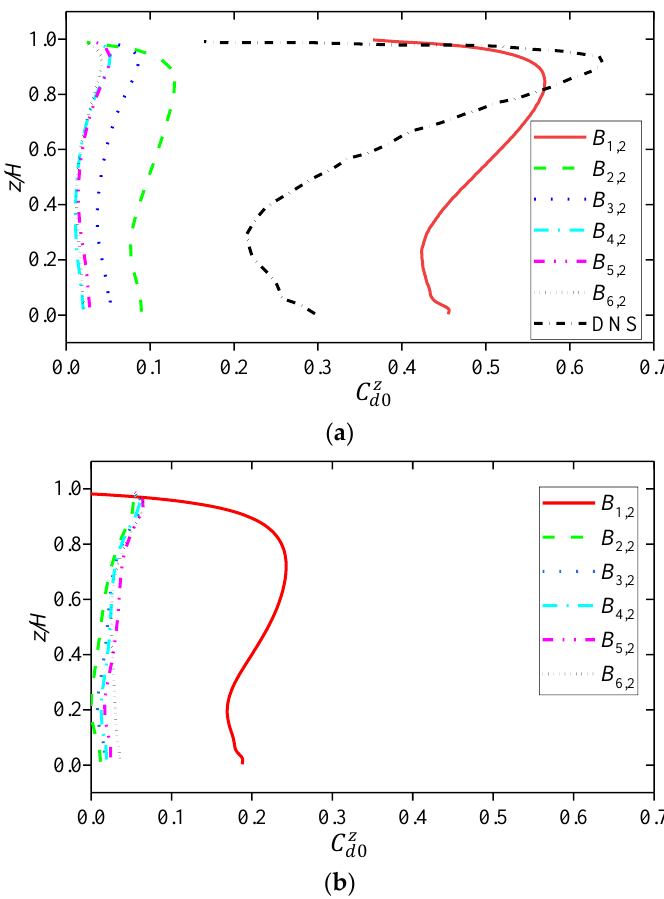
Figure 21. Sectional drag force coefficient 𝐶 𝑑0𝑧 for six pressure modules C 2 along wind direction for ( a ) DWP and ( b ) SWP. The DNS results are from the research of Santiago et al. [47]. Figure 22 further shows the heights H p, which correspond to the peak sectional drag coefficients for the two cases. H p of R 1 and R 2 in DWP are more discrete than those of R 1 in SWP. They increase to 0.89 H and stabilize from R 3, which is lower than 0.92 H in the streamlined case. For DWP, the approaching flow can penetrate R 3 along the wind direction, and then a local flow balance is established from C 3 onward. This can also be inferred from the stable drag force after R 3 in Figure 19a. The flow adjustment distance of three rows is shorter than the two rows in SWP due to the intense flow mixing caused by distorted wind passages. H p values fluctuate more significantly for C 1 , C 2, and C 4 for DWP than for SWP. H p of C 3 remains unchanged after R 3 for both cases, and we can infer that the skipping flow dominates the flow regime in the flow balance region. For DWP, H p of C 2 remains unchanged at 0.92 at R 4 and R 5 and then decreases to 0.89 at R 6. For SWP, H p of C 2 remains unchanged at 0.92. This is because the distorted wind passage causes the recovery of the skipping flow, and it may reattach to the ground, and therefore airflow move down further into the urban canopy. The fluctuation of H p for C 4 is largest in DWP, suggesting that the flow over C 4 interferes with its adjacent wind passages, verified by the most significant drag force for C 4